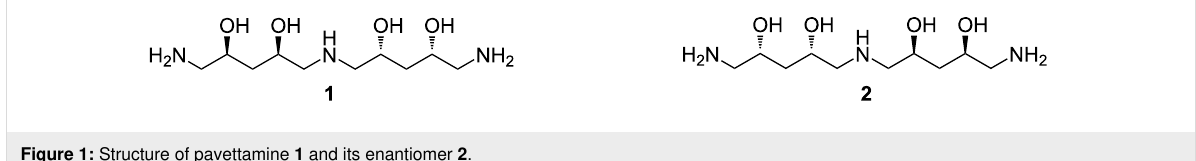
logical studies have shown that this toxin is responsible for “quick disease” (gousiekte) in ruminant animals, which causes inhibition of protein synthesis in the cardiovascular organs